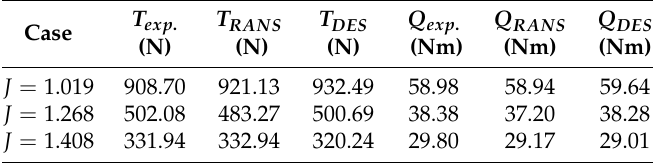
Table 6. Results for thrust ( T ) and torque ( Q ) obtained using RANS and DES models at different advance ratios J